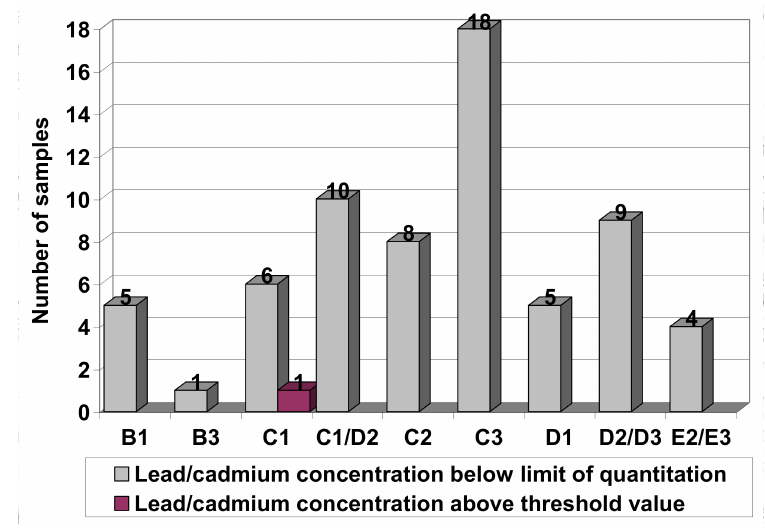
Figure 5. Distribution of the number of produce samples based on cadmium concentration and respective quadrants in Baroševac.